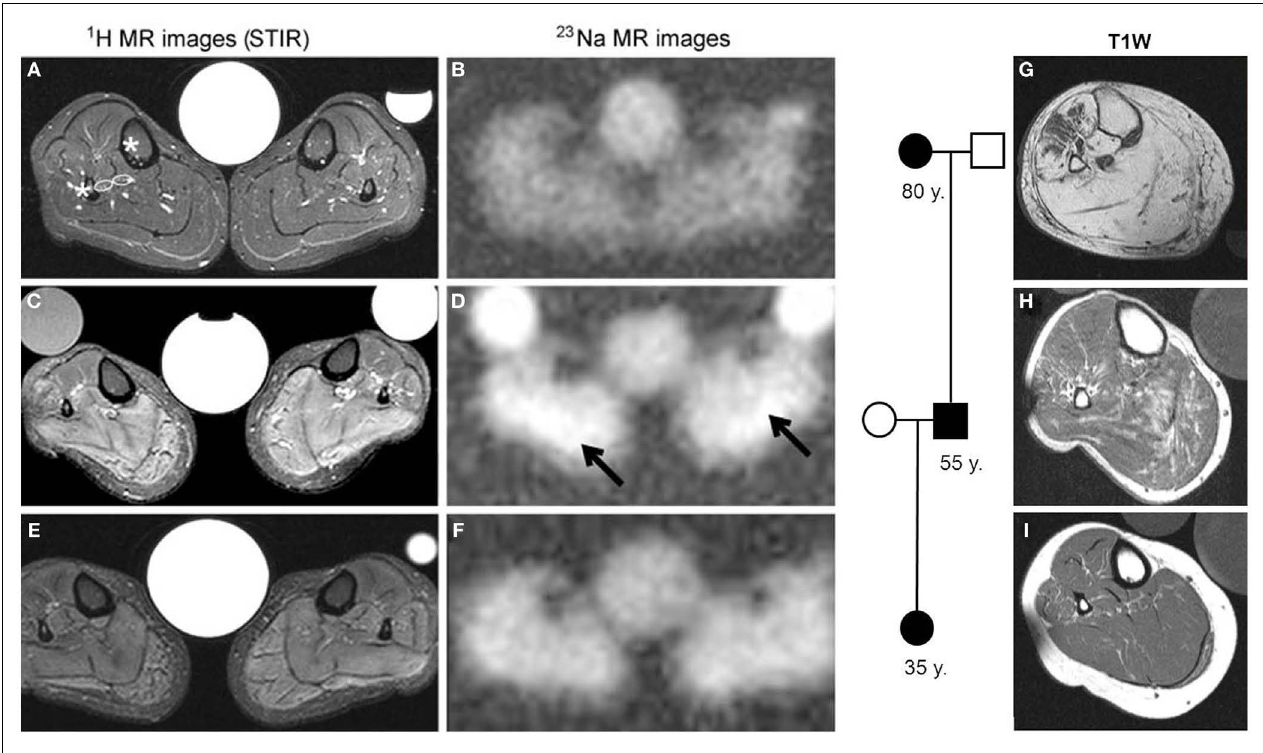
FIGURE 5 | 1 H and 23 Na measurements in the calf muscles of HypoPP patients. (A–F) T2-weighted STIR 1 H (left) and 23 Na-MR images (right) from a healthy control (A,B) and the propositus of a HypoPP family, a 37-year-old female harboring the Cav1.1-R1239H mutation (C–F) .The images in (C,D) were taken before treatment and the images in (E,F) were taken after treatment with 250mg/d acetazolamide for 4weeks. Note the very high proton intensities in STIR (C) and the elevated Na + concentration before treatment (D) ,